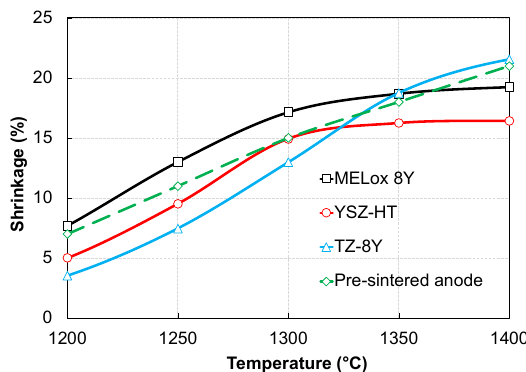
Fig. 9 Comparison of the sintering shrinkage between the pre-sintered anode and YSZ powders.